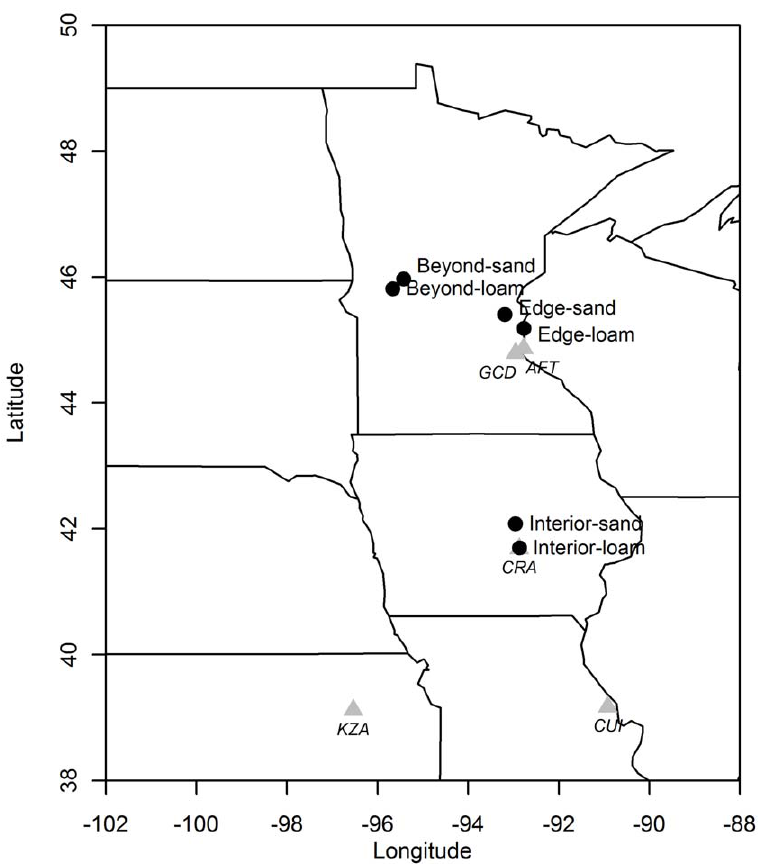
Figure 1. Map of seed source populations and transplant common garden locations. Seed source populations (Table S1) are marked by triangles (KZA: Konza Prairie Biological Station; CUI: Cuivre River State Park, CRA: Conard Environmental Research Area; GCD: Grey Cloud Dunes Scientific and Natural Area; AFT: Afton State Park). Common garden locations (Table S2) are marked by black circles. The dotted line is the approximate range edge in this region, based on USDA Plants Database county level information.